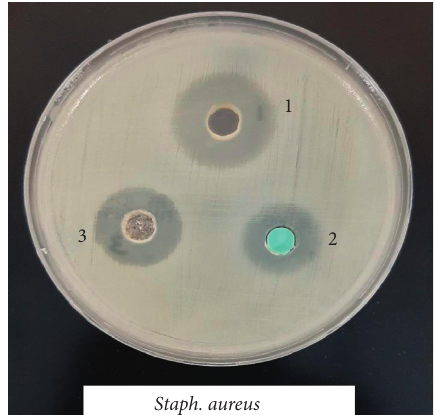
Figure 17: Microbiological screening of Ni(II), Cu(II) and Mn(II) complexes against Aspergillus fumigatus.